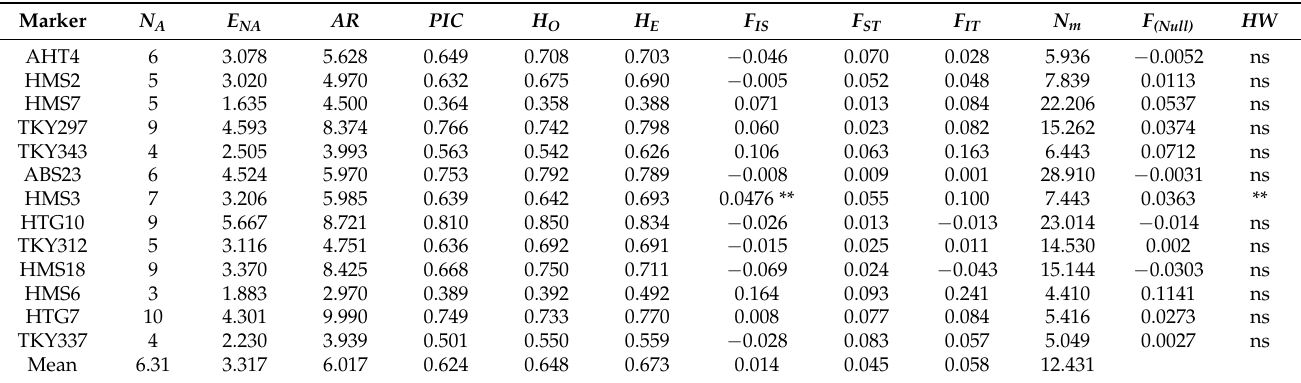
Table 3. Indices of genetic diversity of the whole sample ( n = 120) for the Littoral-Dinaric donkey and Istrian donkey breeds.